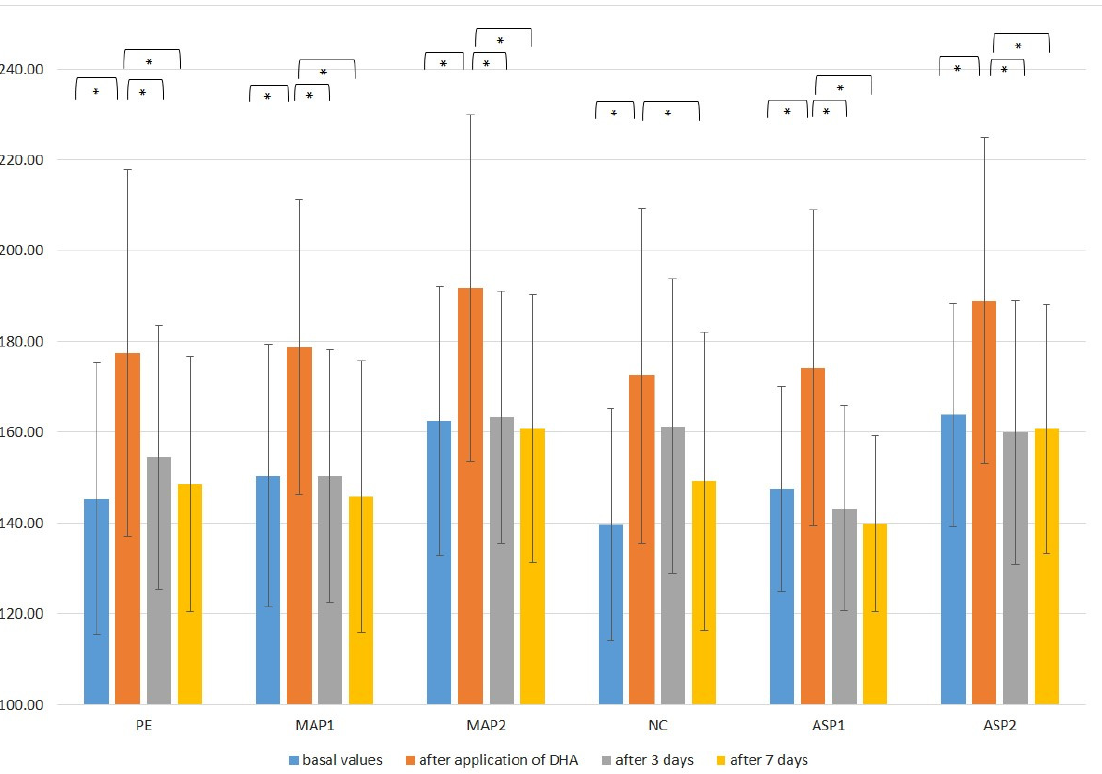
Figure 6. In vivo determined mean values with a standard deviation of melanin index (MI) for non-treated control (NC), placebo emulgel (PE) and investigated emulgels (ASP1, MAP1, ASP2 and MAP2) after 3 and 7 days of application. Significant differences are marked with * ( p < 0.05).